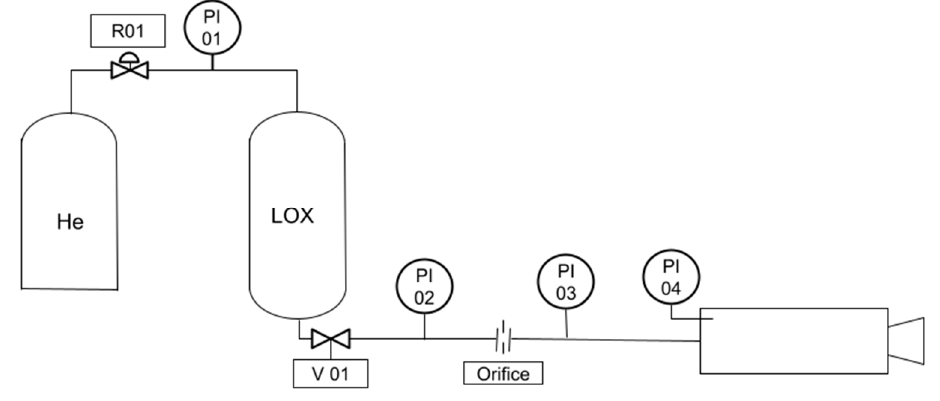
Figure 3. Test Setup. Table 1. Motors used in this research.